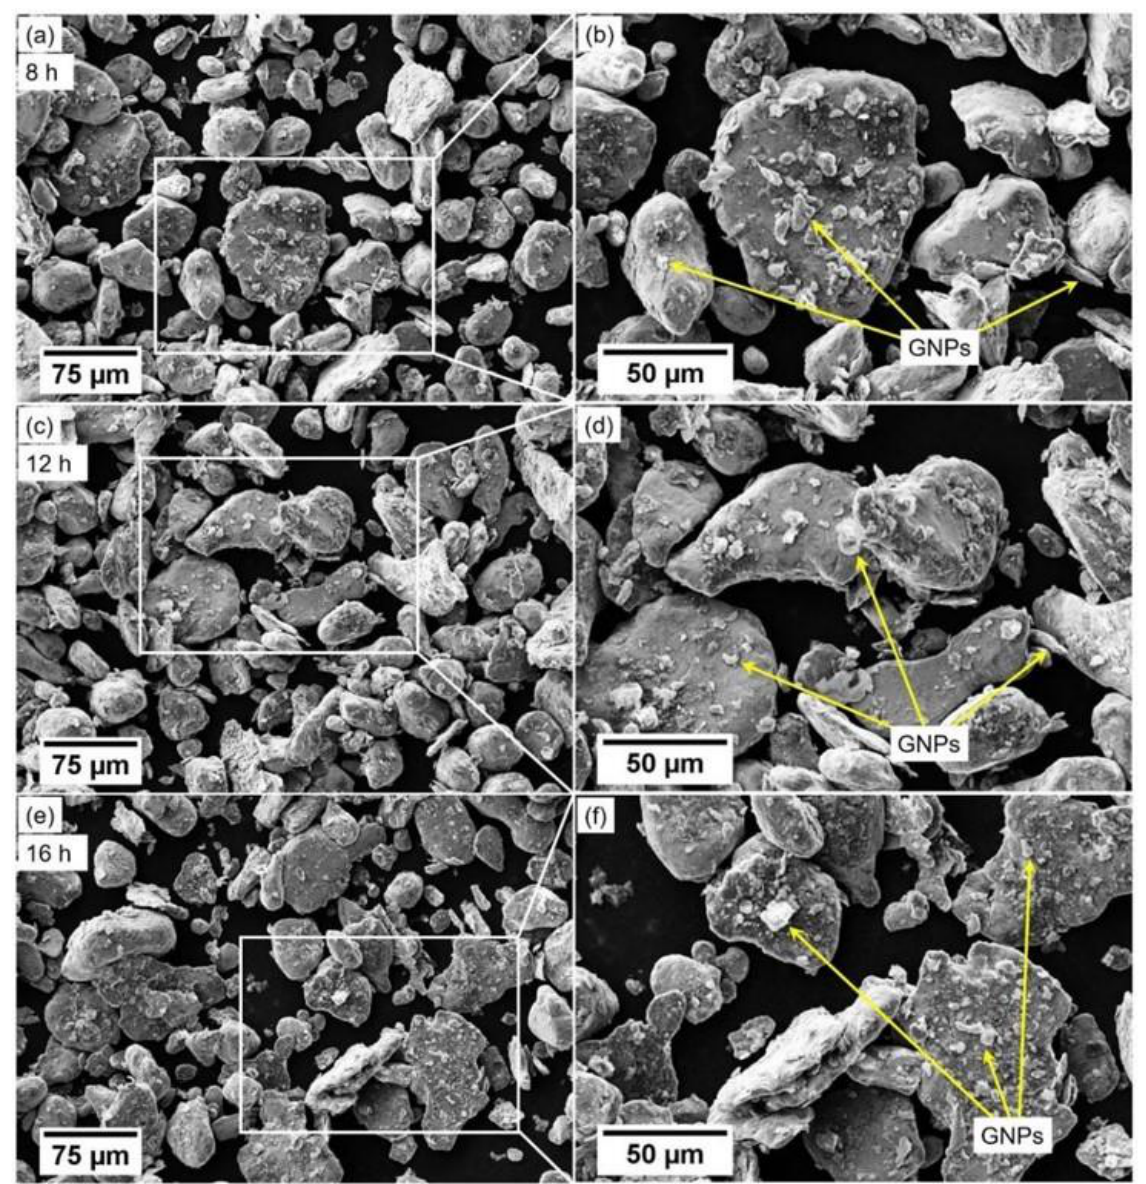
Figure 8. SEM images showing the morphological alteration of powders and the dispersion of agglomerated GNPs in the milled alloys for ( a , b ) 8 h, ( c , d ) 12 h and ( e , f ) 16 h with magnified images. Longer milling times, ranging from 8 to 16 h, visibly changed the powder morphology from nearly spherical to flat, as shown in Figure 8. The plastic deformation of the powder with long milling times becomes more obvious because of the continuously applied impact energy. While the PCA protects the powder against plastic deformation during short milling times (as stated above), the particles cannot tolerate continuous mechanical defor- mation due to the work-hardening effect at longer milling times [60]. The powder keeps flattening throughout the mechanical milling process, but cold welding did not appear until after 16 h. A similar effect of low-speed ball milling has been observed for CNT-